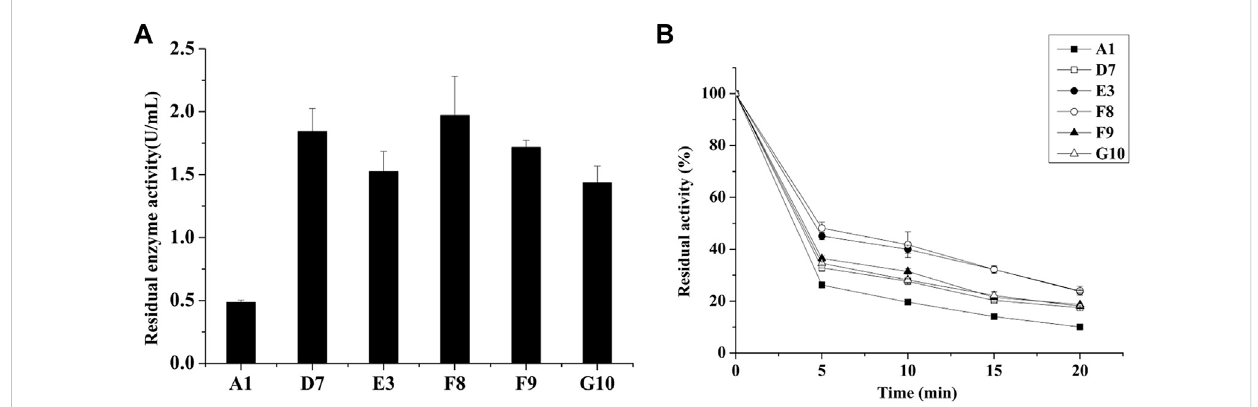
FIGURE 1 Screeningofthermostablemutantsinthe E.coli BL21host. (A) Residualactivitiesofparentandmutantsaftertreatmentat80 ° Cfor20 minin96-well plates. (B) Expression of thermostable mutants in E. coli and determination of thermostability after treatment at 80 ° C.